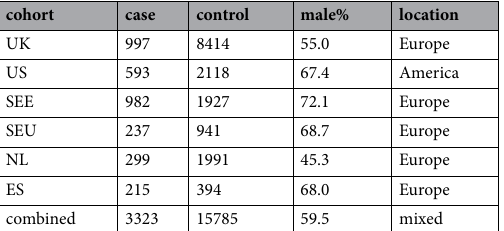
Table 1. Summary information of study cohorts and the combined data.